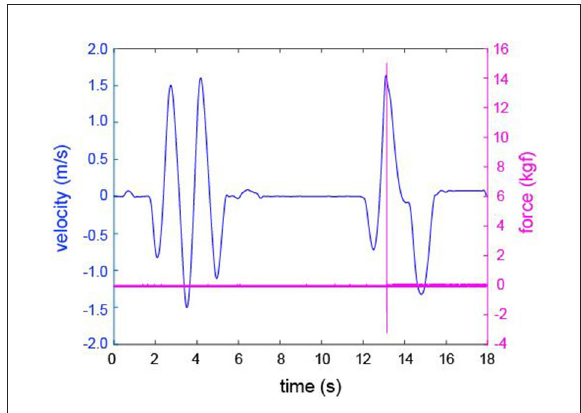
FIGURE3 An example of data acquired by the motion capture system and the collision pressure measuring device. The left side y-axis and blue plots show the velocity of the putter head, and the right-side y-axis and pink plots show the value of the collision pressure measuring device. In the case of this figure, the actual hit was made after two practice swings. The peak value of force (around 13s) indicates the impact. In this figure, the length of time is normalized. That is, the measurement frequencies (240Hz and 10kHz) of both devices are actually different.